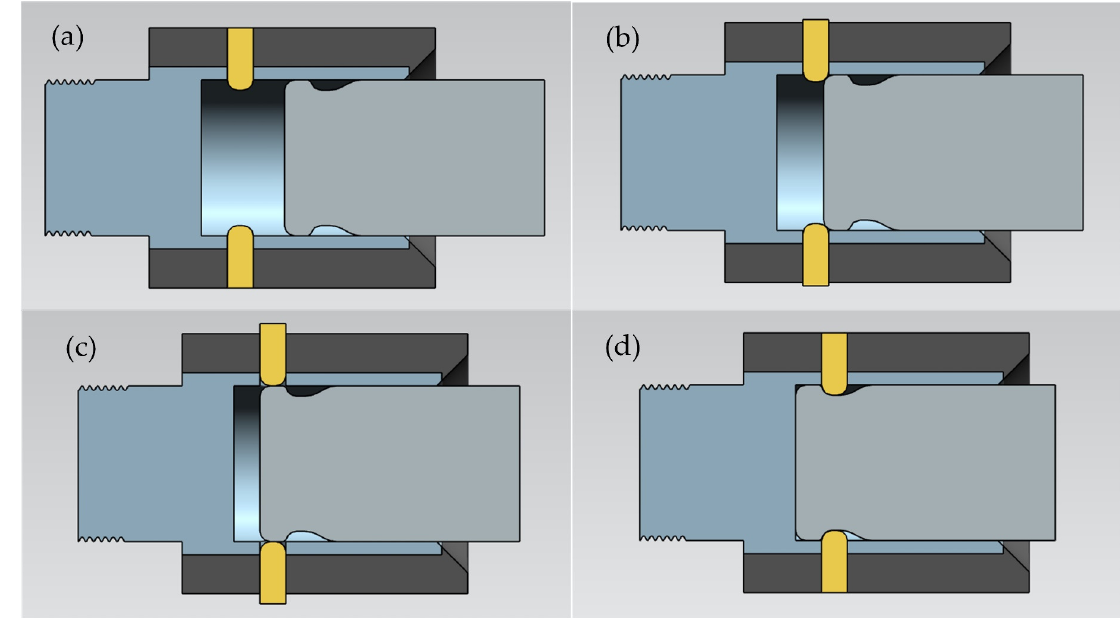
Figure 16. The latching mechanism of TE Connectivity HydraElectric WMCs: ( a ) plug and receptacle prior to latching, ( b ) plug starts of engaging with receptacle, ( c ) pin makes maximum engagement with receptacle, and ( d ) pin makes fully mated with receptacle [95].